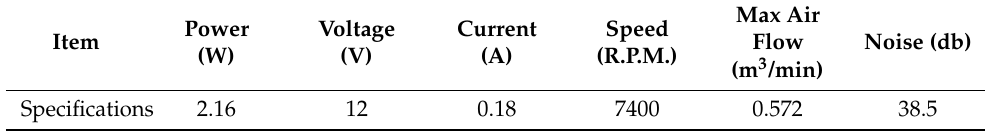
Table 4. Technical details of the fan.